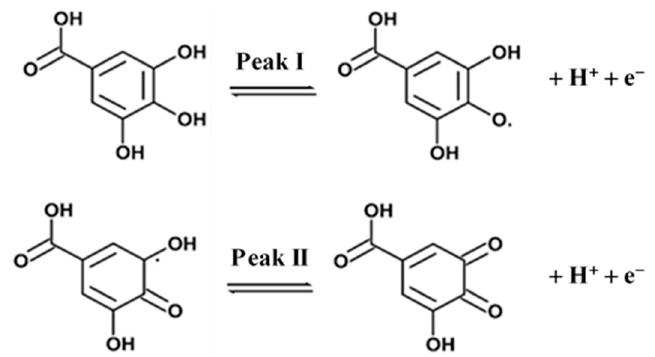
Scheme 1. Proposed pathway for electrochemical oxidation of GA.